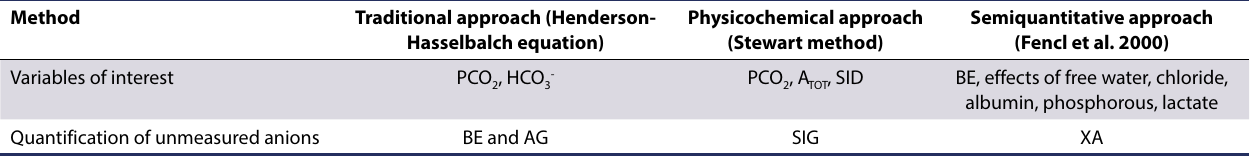
Physicochemical approach Semiquantitative approach Hasselbalch equation) (Stewart method) (Fencl et al. 2000) albumin, phosphorous, lactate